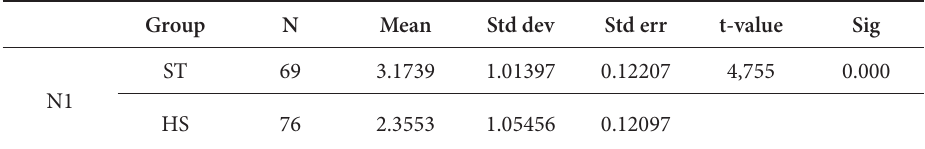
Table 11. Two-group mean differences for training